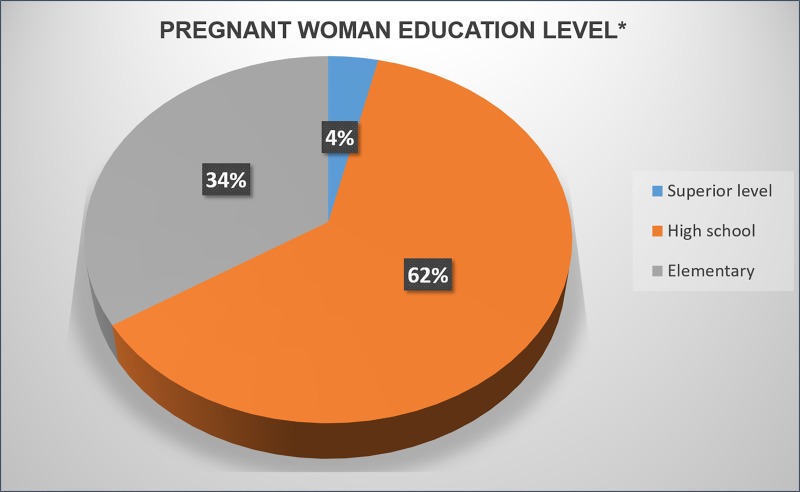
Distribution of level of education of pregnant women in the study.